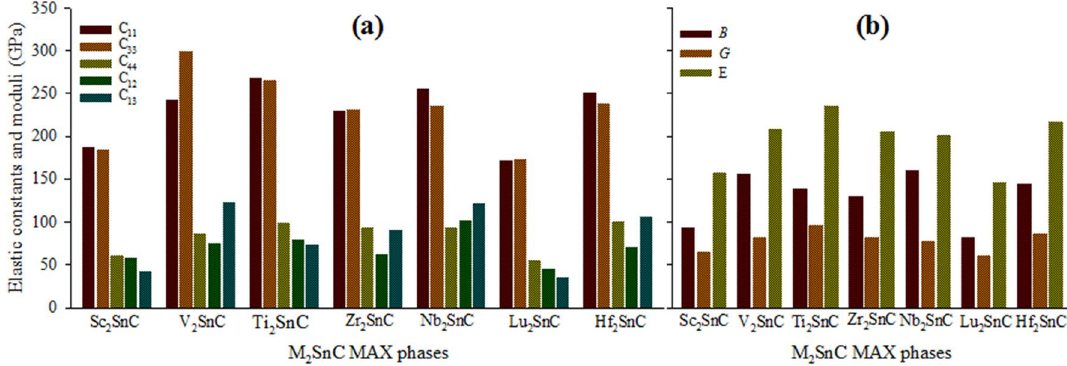
Figure 3. ( a ) Elastic constants C ij and ( b ) elastic moduli B , G , and E of Sc 2 SnC and other MAX